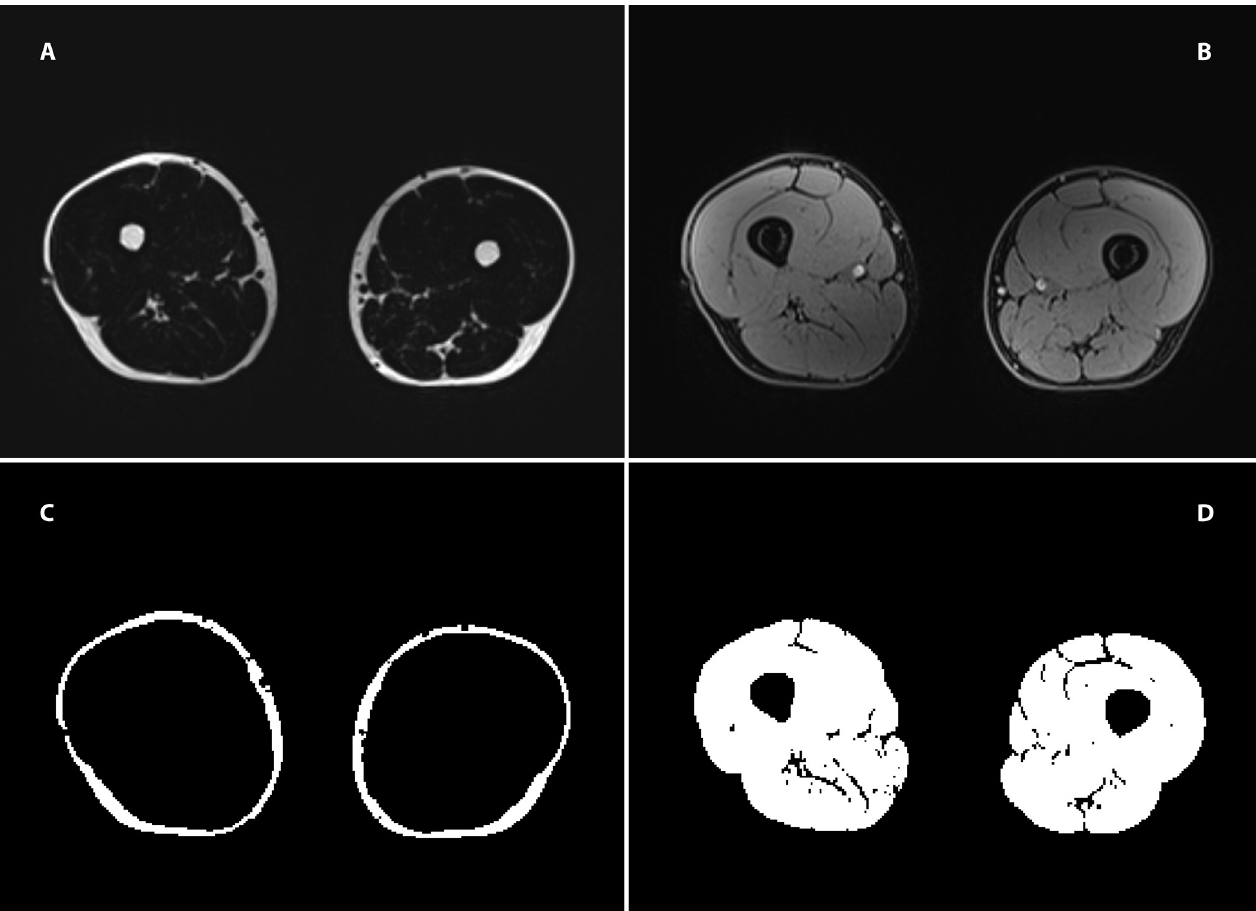
Fig 1. MR images of the thigh. First row: MRI images acquired using the 2-point DIXON sequence. (A) the "fat-only” image; (B) the "water-only” image. Second row: (C) the segmentation result of a patient’s SAT; (D) the segmentation results of the muscle area.